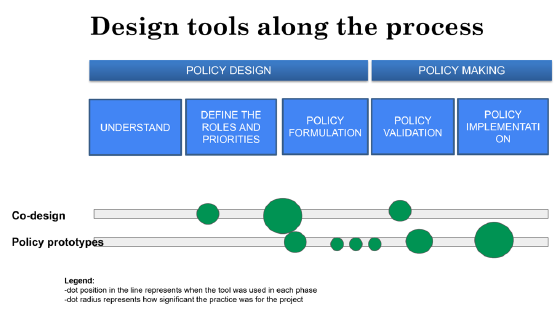
Fig. 5 . Practices used in the different phases. Note: the whole process happenedd as a co-design inter-organizational process (see Tab. 1), but the co-design process mentioned in this figure reports to the involvement of the whole set of stakeholders (Companies, Finances, and Banking, Unions, Schools,